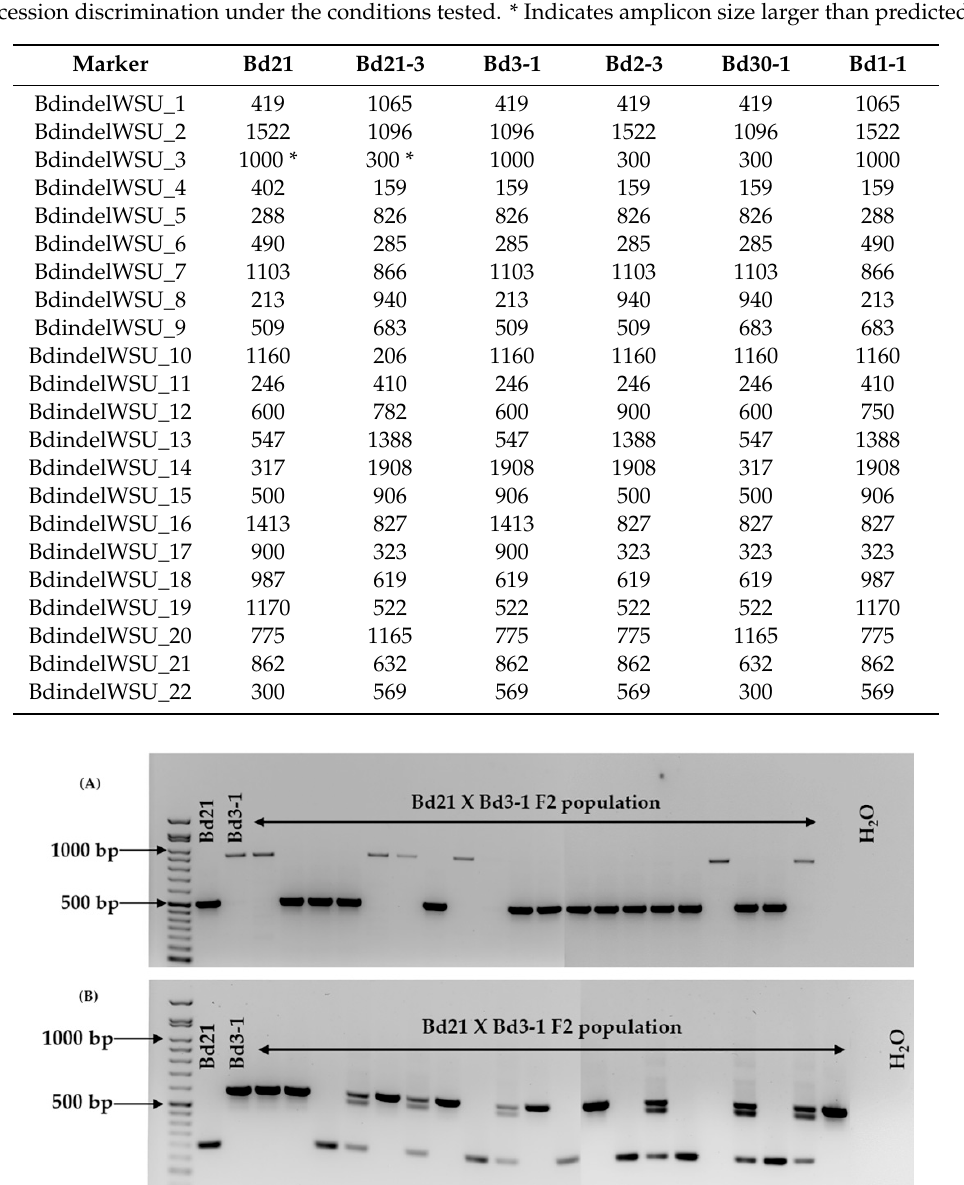
Figure 3. BdindelWSU_15 ( A ) and BdindelWSU_22 ( B ) tested on a Bd21 x Bd3-1 F2 population. The amplicons were visualized on a 1.5% agarose gel stained with ethidium bromide. The GoldBio ® 50 bp DNA ladder was used for amplicon size determination.